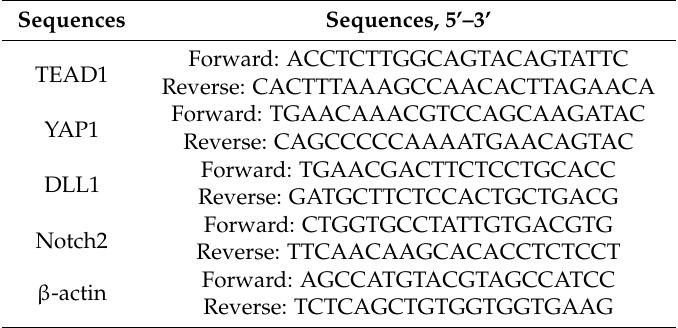
Table 1. Primers for quantitative polymerase chain reaction.